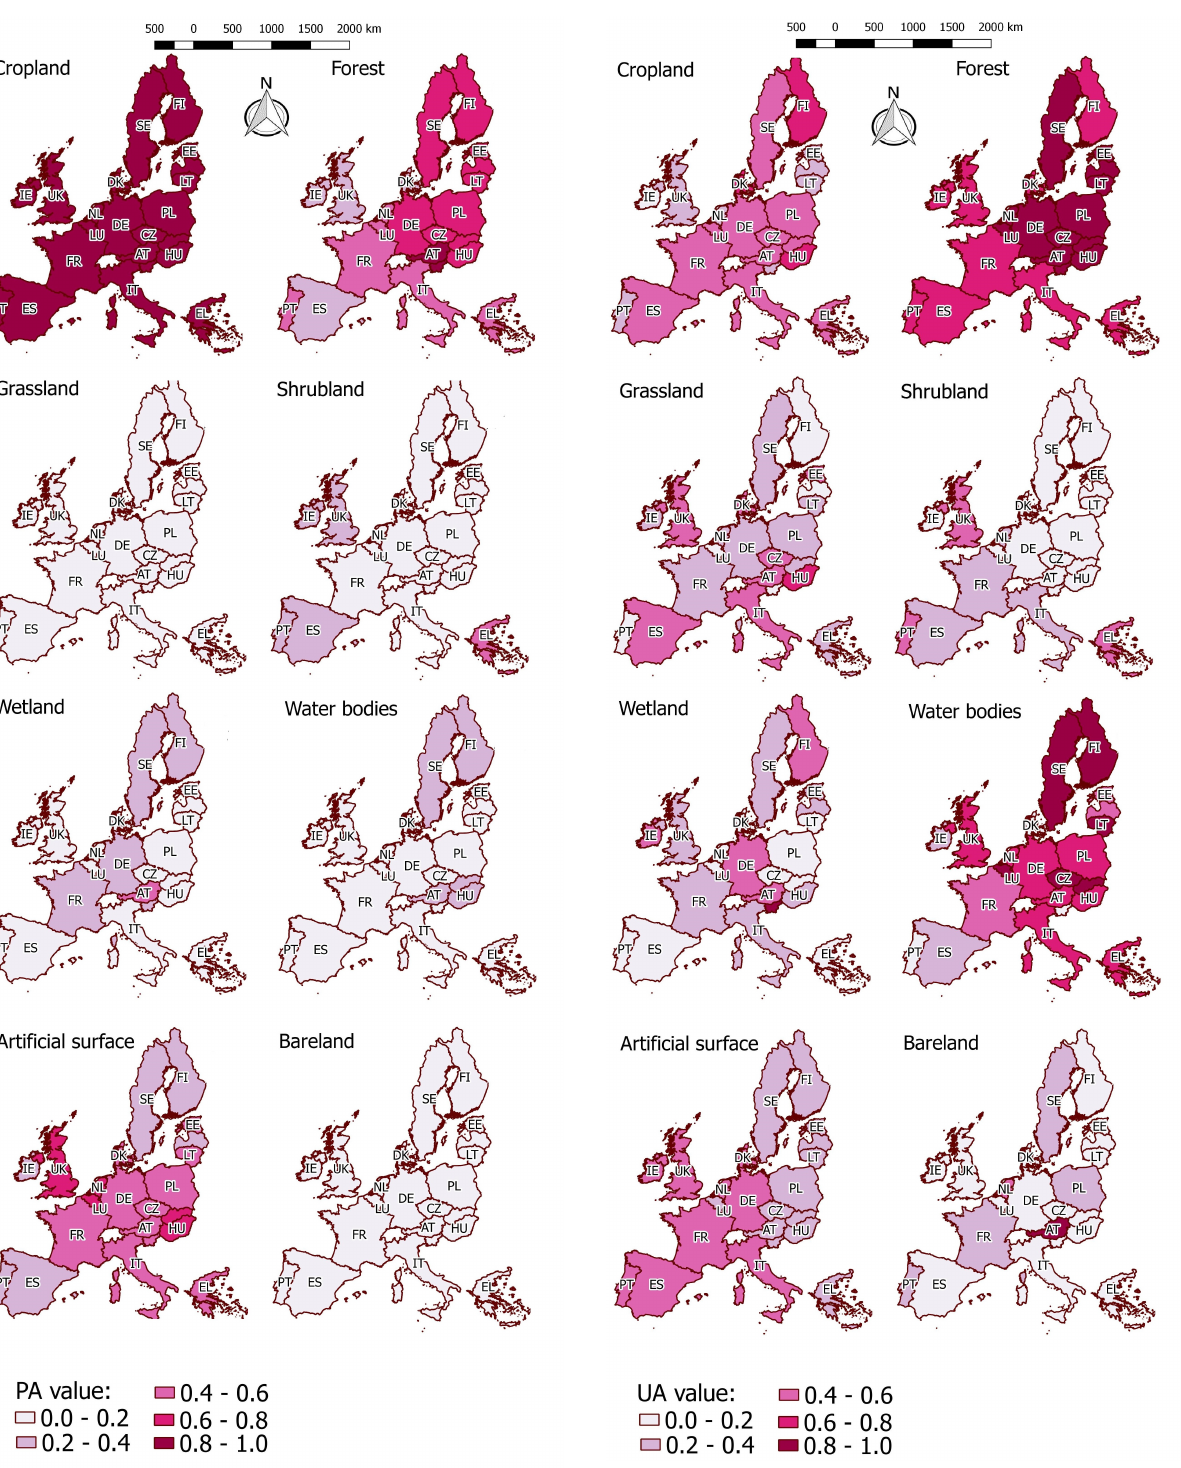
Figure 2. User’s accuracy for each country